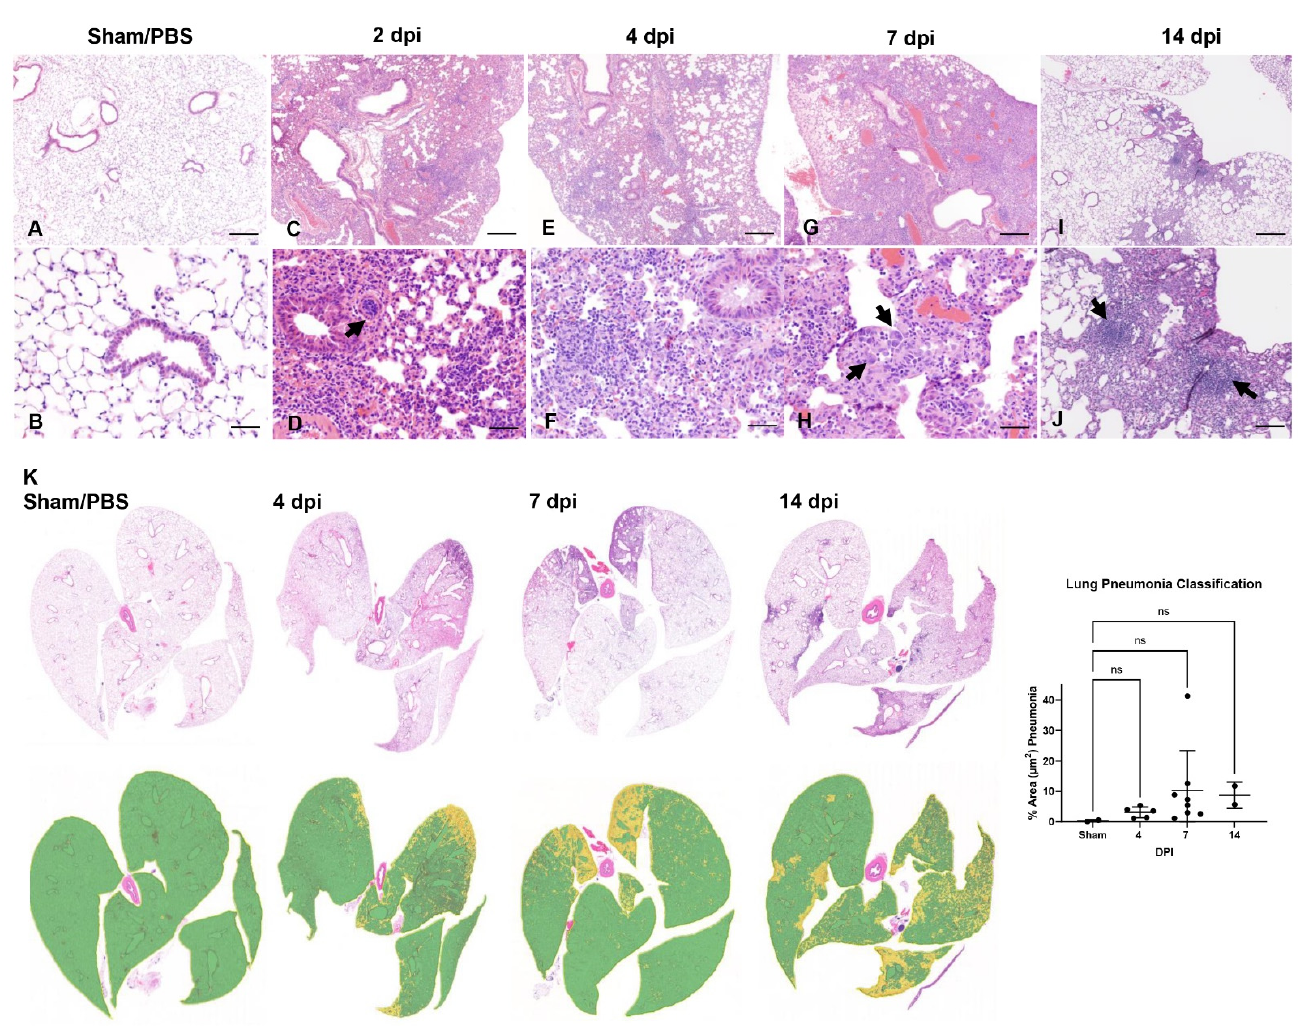
Figure 3. Temporal qualitative and quantitative analysis of SARS-CoV-2 pneumonia in K18-hACE2 mice. Lung tissues from non-infected mice (PBS/Sham inoculated: ( A , B ) and from infected mice at 2 dpi ( C , D ), 4 dpi ( E , F ), 7 dpi ( G , H ) and 14 dpi (n = 2; I , J ) following intranasal inoculation were analyzed. Subgross histological images of the lungs and corresponding pneumonia classifiers for each timepoint are depicted in panel ( K ) (green = normal; yellow = pneumonia). Mild-to-moderate interstitial pneumonia was evident starting at 2 dpi with frequently reactive blood vessels ( D , arrow). At 7 dpi, alveolar type 2 (AT2) cell hyperplasia was observed ( H , arrows). Residual mild-to-moderate pneumonia was observed in the two male survivors at 14 dpi from the survival curve, with rare sporadic lymphoid aggregates ( J -arrows). H&E, 50 × ( A , C , E , G , I ; bar = 500 µ m), 200 × ( B , D , F , H , J ; bar = 100 μ m) and 1X ( K ) total magnification. Pneumonia classifier: PBS/Sham (n = 2), 4 dpi (n = 5), 7 dpi (n = 8), 14 dpi (n = 2). One-way ANOVA; ns, non-significant.